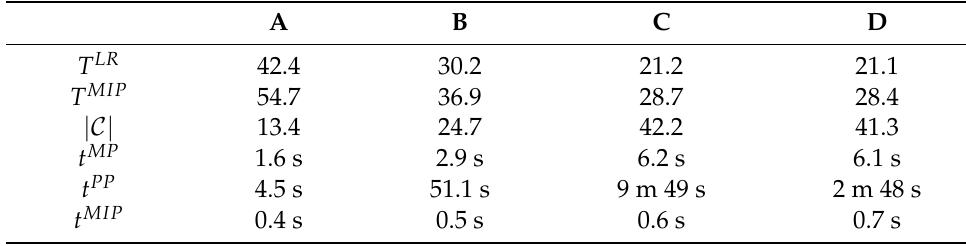
Table 6. Optimization model efficiency-small